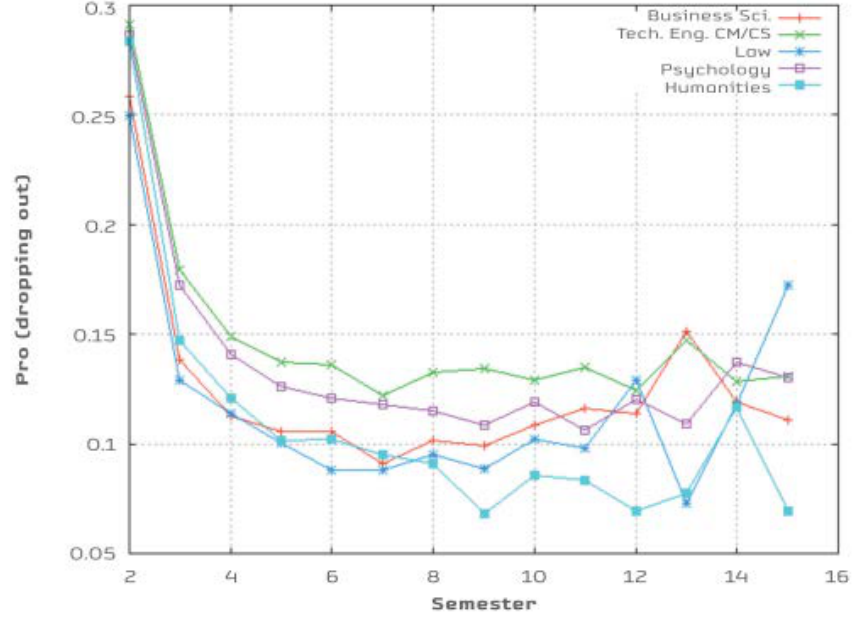
Figure 1 . Probability of dropping out before starting a new